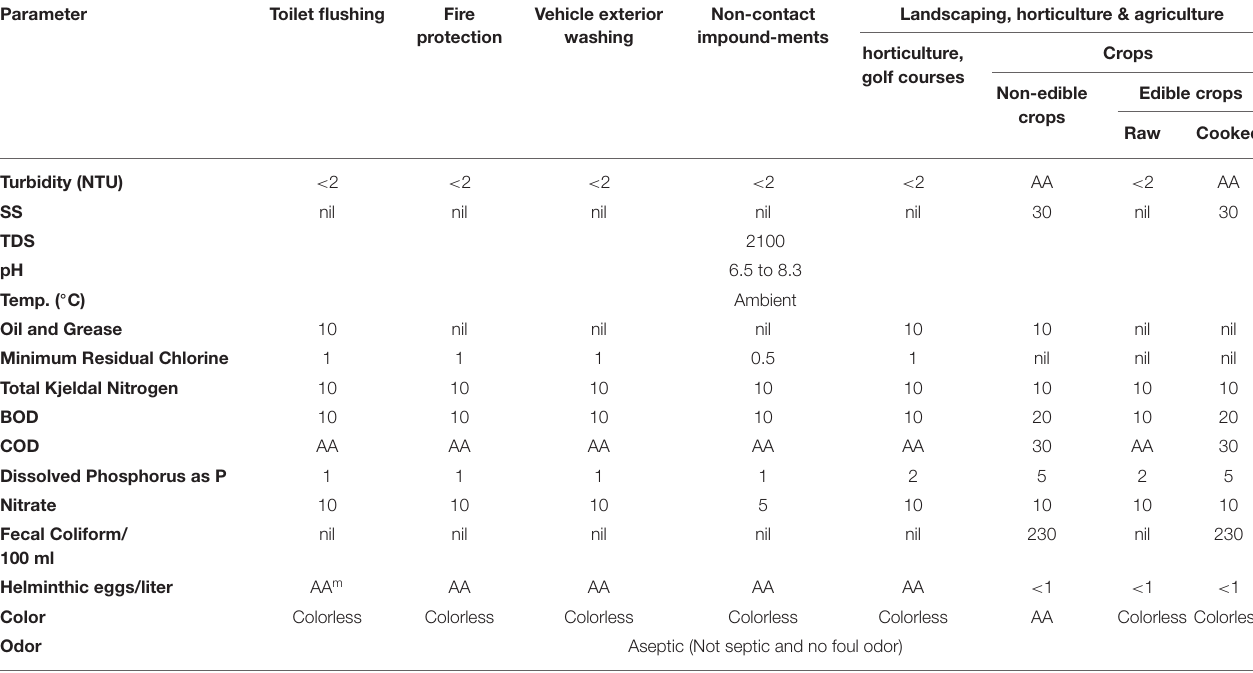
TABLE 6 | Recommended norms of treated sewage quality for different uses (CPHEEO, 2013). Parameter